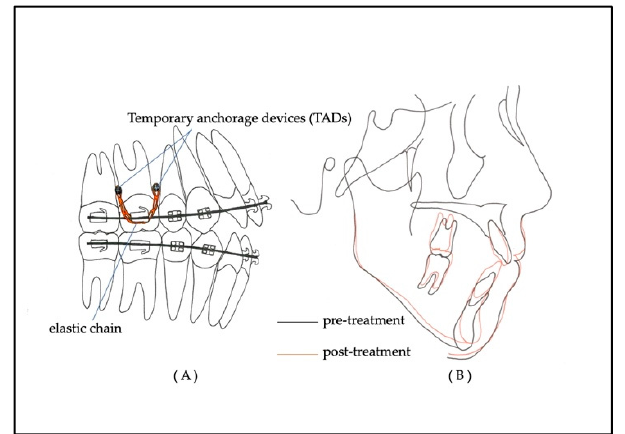
Figure 3. ( A ) A schema of orthodontic treatment of open bite with intruding molars using a multi- bracket appliance system and TADs. ( B ) Superimposition of cephalometric trace changes pre- and post-treatment.